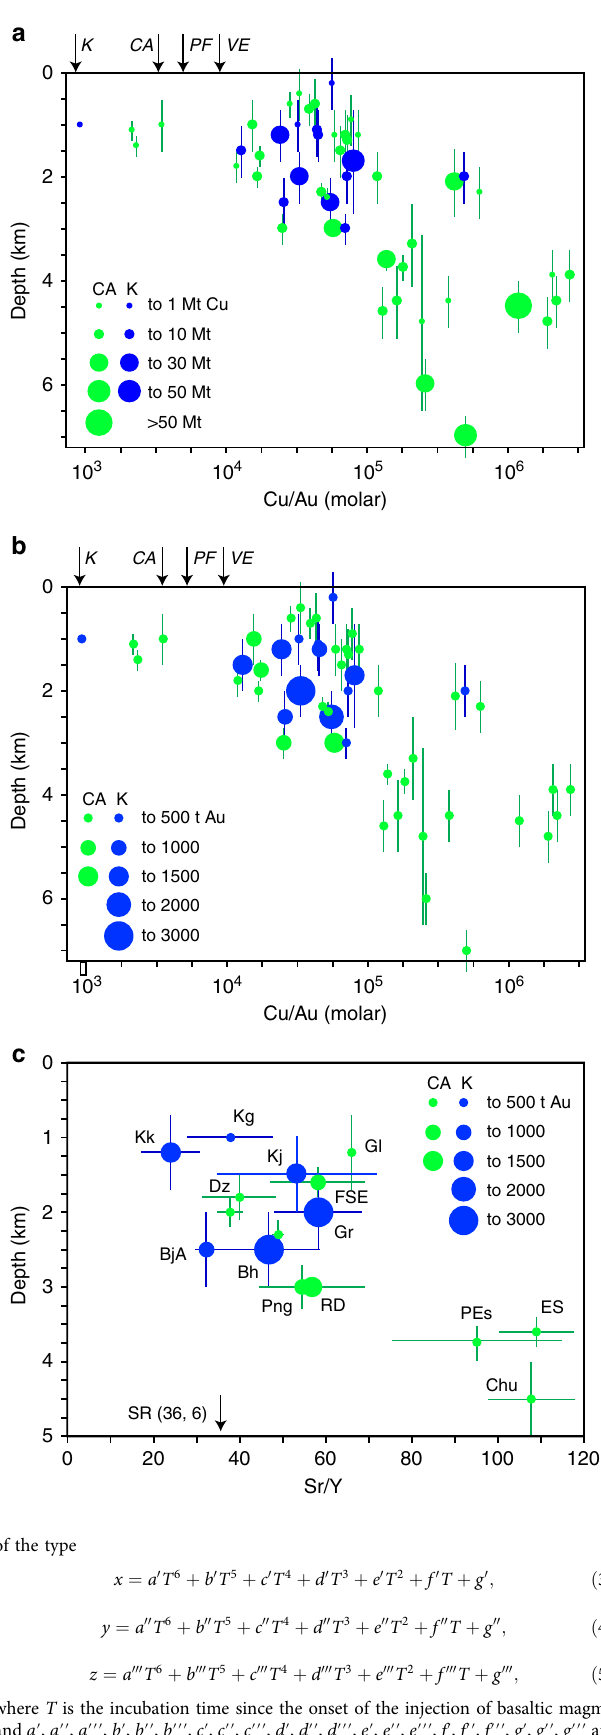
Fig. 5 Depth of formation vs. Cu/Au molar ratios of porphyry Cu-Au deposits and Sr/Y average values of associated magmatic rocks. The size of the symbols corresponds to different copper ( a ) and gold ( b , c ) tonnages as indicated in the legend. Green and blue colours of the symbols refer respectively to calc-alkaline (CA) and high-K calc-alkaline to alkaline (K) magmatic systems. The error bars associated with depth values are from ref. 28 (Supplementary Data 1). The bars for Sr/Y values are 1 s.d. uncertainties calculated from the available Sr/Y values of magmatic rocks associated with each deposit (see Supplementary Data 1). Abbreviations of